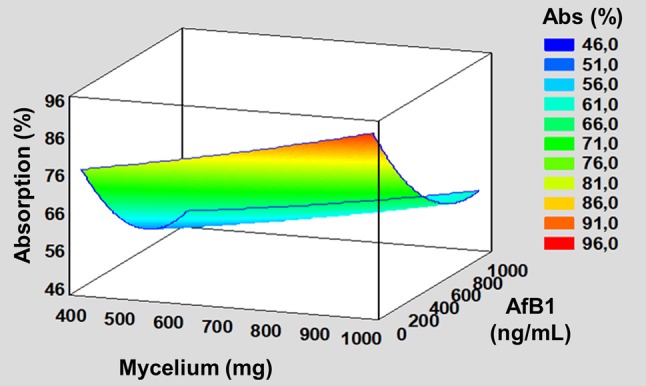
Estimate response surface plot for the effect of mass of adsorbent and mycotoxin concentration on the AfB1 removal.